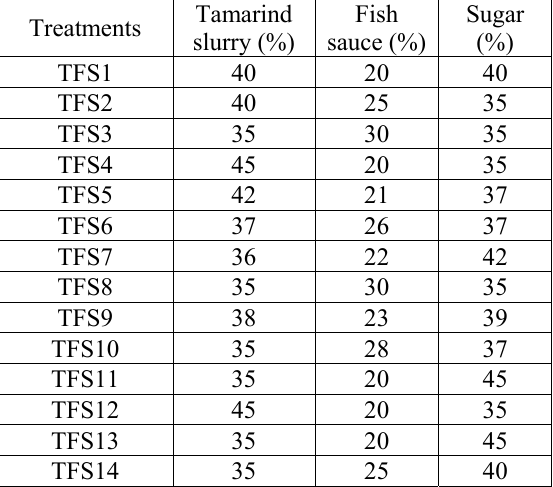
Table 1. Experimental formulations of Vietnamese tamarind fish sauce obtained from a mixture design program Tamarind Treatments